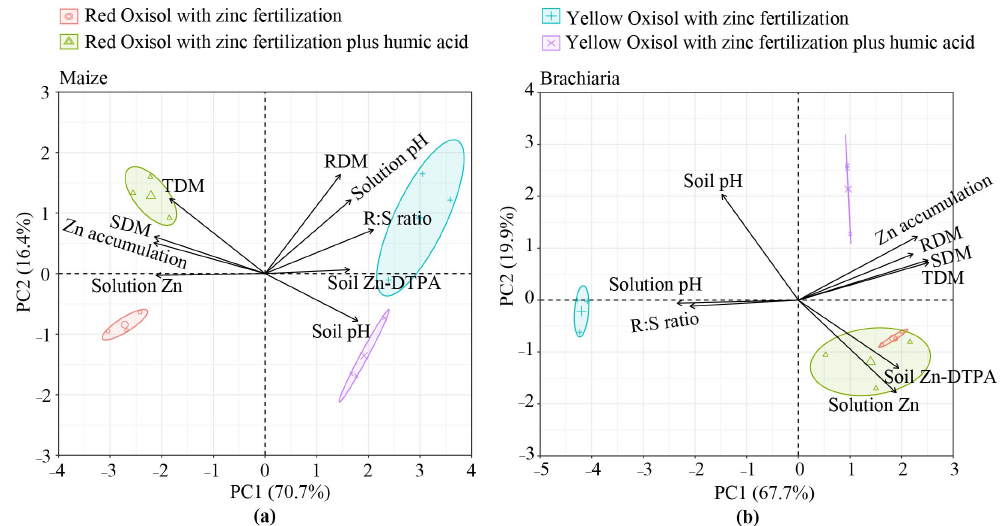
Figure 5. Biplot of principal component analysis (PCA) separated according to the crop grown in both Oxisols. The main clusters of plant traits and soil attributes in response to Zn with/without humic acid (HA) use are shown in PCA graphs. The maize experiment variables ( a ); brachiaria experiment variables ( b ); SDM, RDM and TDM: shoot, root and total dry matter production, respectively; R:S ratio: ratio between shoot (SDM) and root (RDM) biomasses; Zn accumulation: Zn accumulated in shoot.